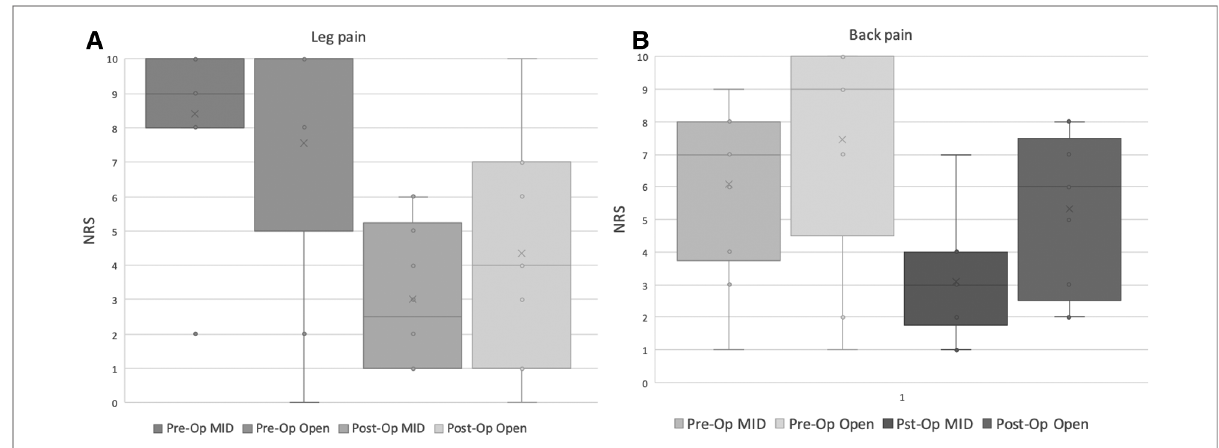
FIGURE 5 Distribution of reported rating scale (NRS) for preoperative and postoperative leg ( A ) and back ( B ) pain, in the MID and open decompression groups.